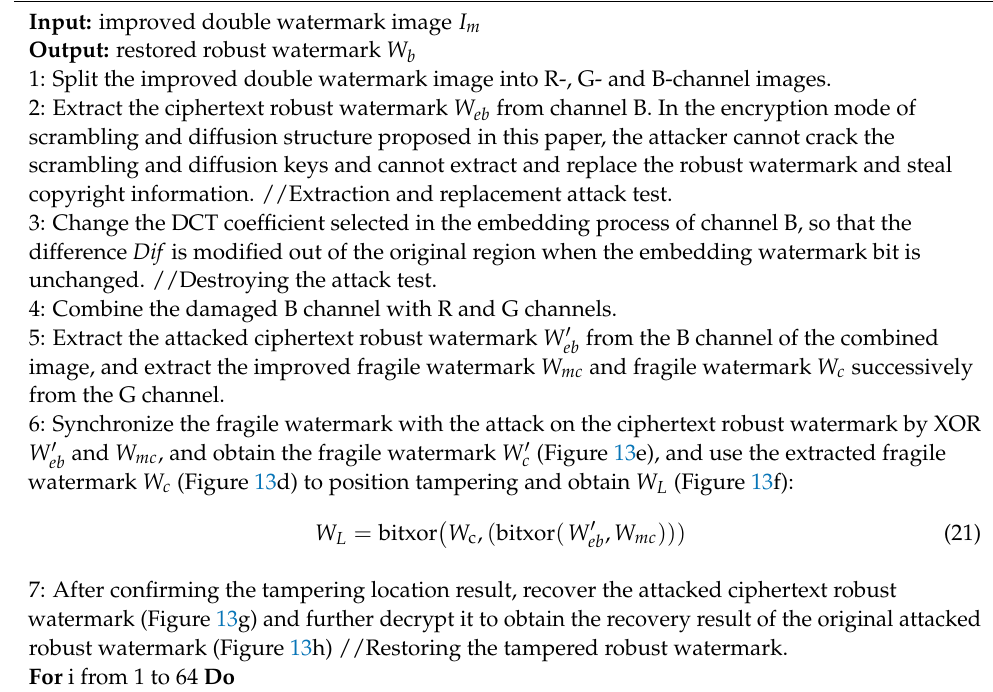
Algorithm 8: Simulation Test and Robust Watermark Recovery